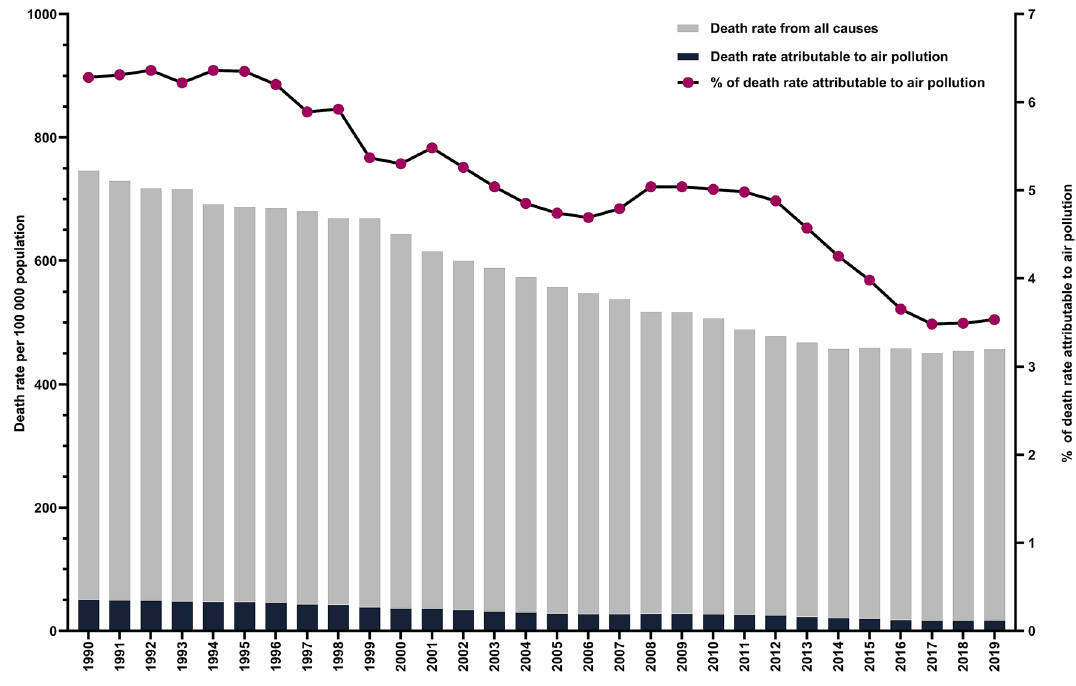
Figure 3. Median European death rate from 1990 to 2019.